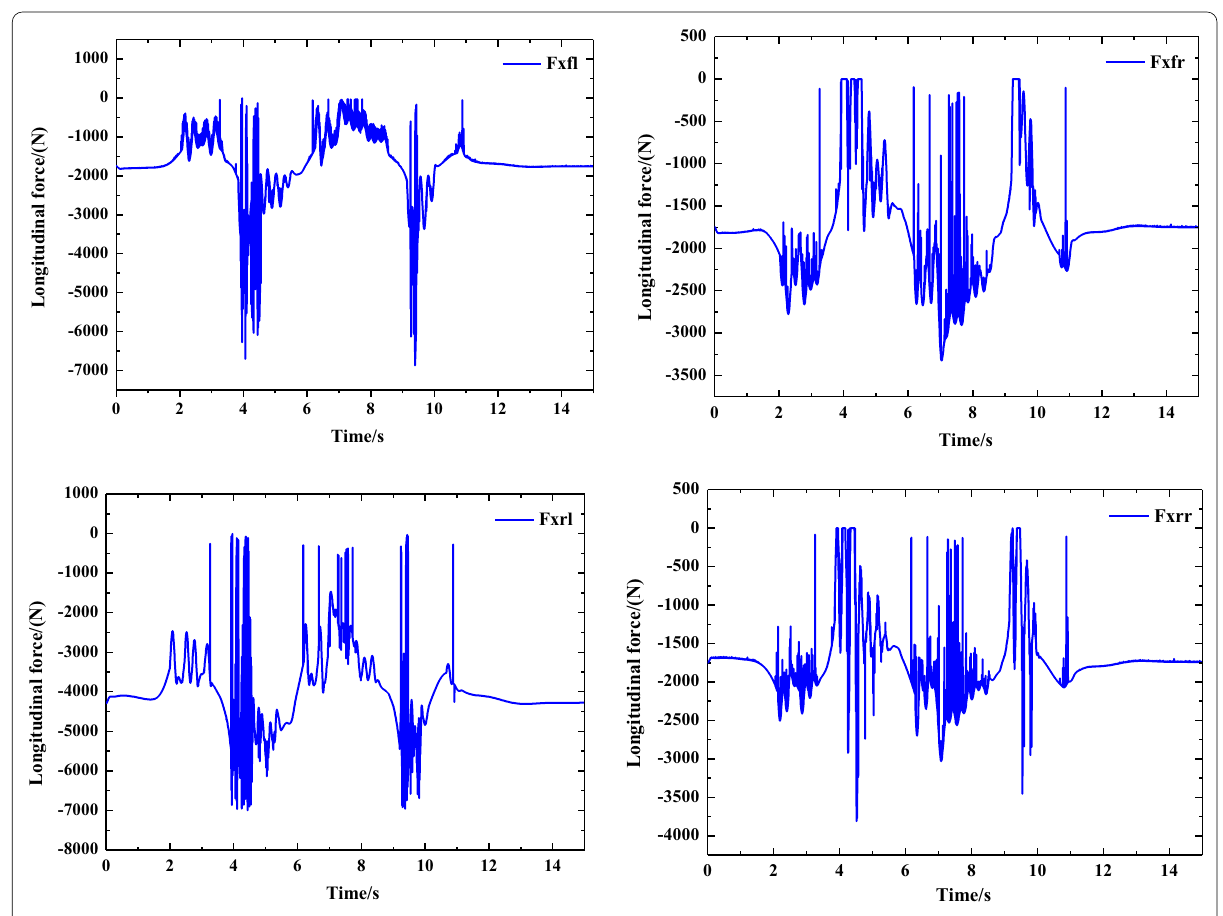
Figure 10 Tire forces allocation results based on the robust least-squares control allocation method ( μ